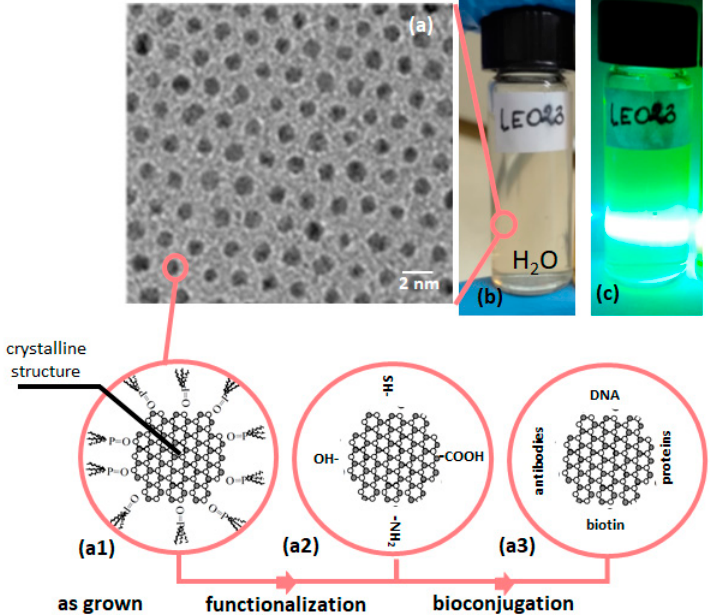
Figure 1. ( a ) TEM image of hydrophilic CdSe quantum dots. Schematic structure of selected quantum dot after synthesis ( a1 ), after surface functionalization (with examples of most typical functional groups) ( a2 ) and after bioconjugation (with examples of most common biomolecules used for detection/targeting) ( a3 ). ( b , c ) Digital images of CdSe quantum dots dispersed in water with and without laser excitation.